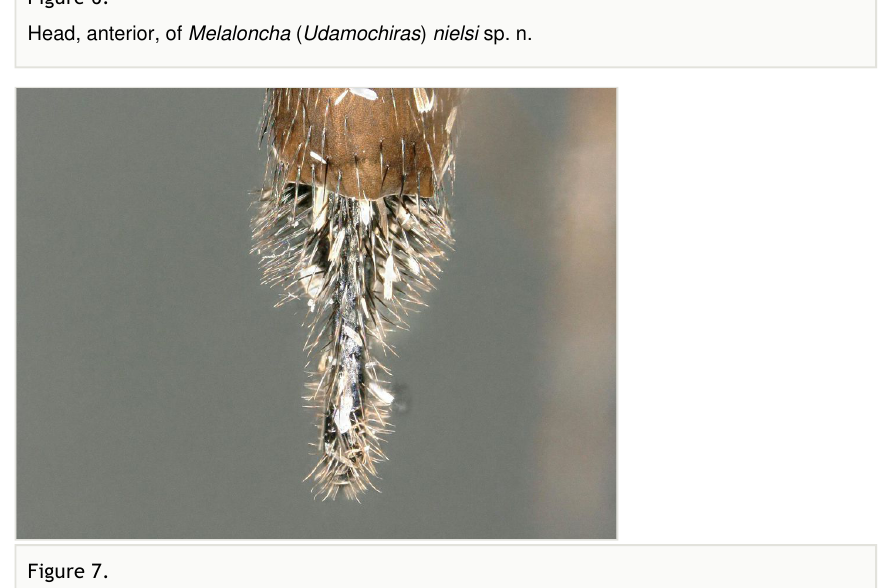
Oviscape, dorsal, of Melaloncha ( Udamochiras ) nielsi sp.